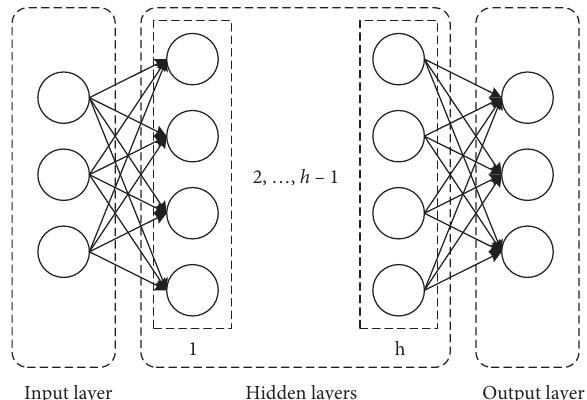
Figure 1: Deep neural